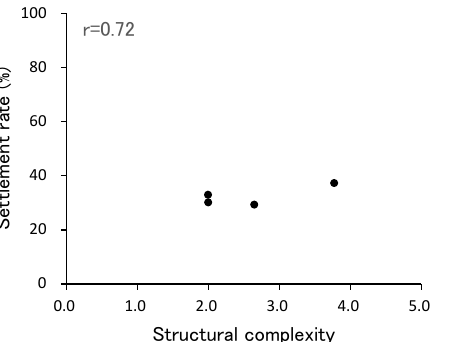
Figure 4. Correlation between settlement rate and structural complexity in the substrata.